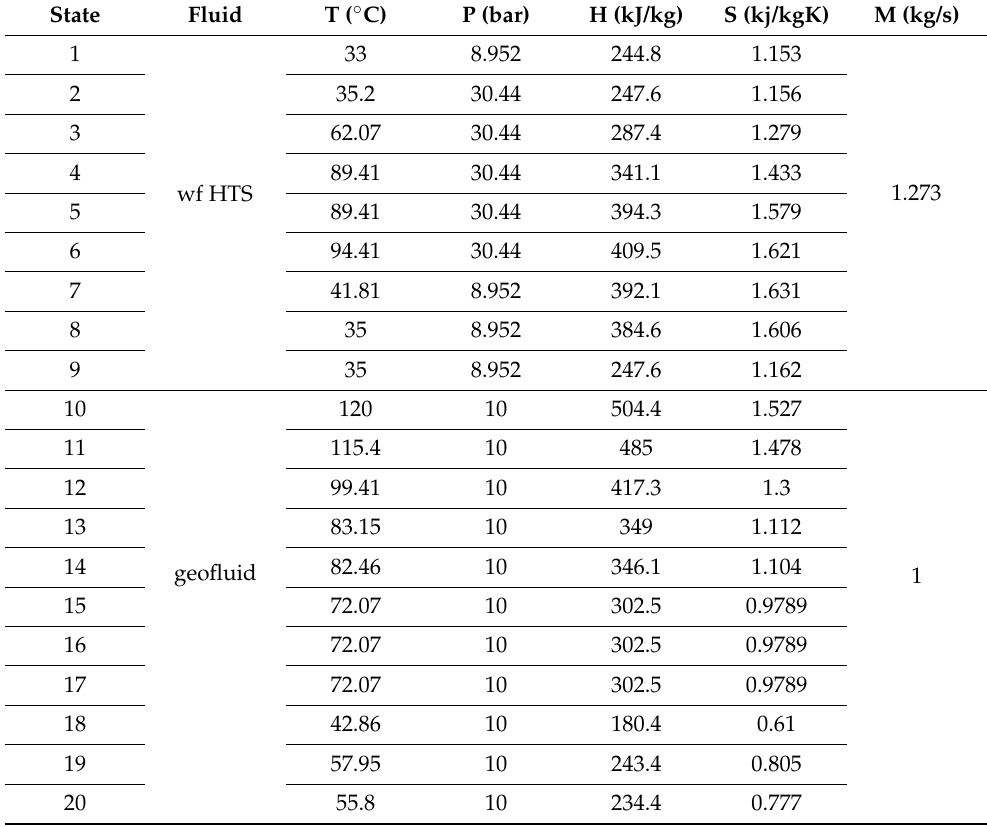
Table A7. Thermodynamic states of the working fluids, geothermal fluid (water), and cooling fluid (air) in characteristic points of the DS parHTSLTPH ORC configuration with R1234yf in HTS and LTS stages for a geothermal fluid temperature of 120 ◦